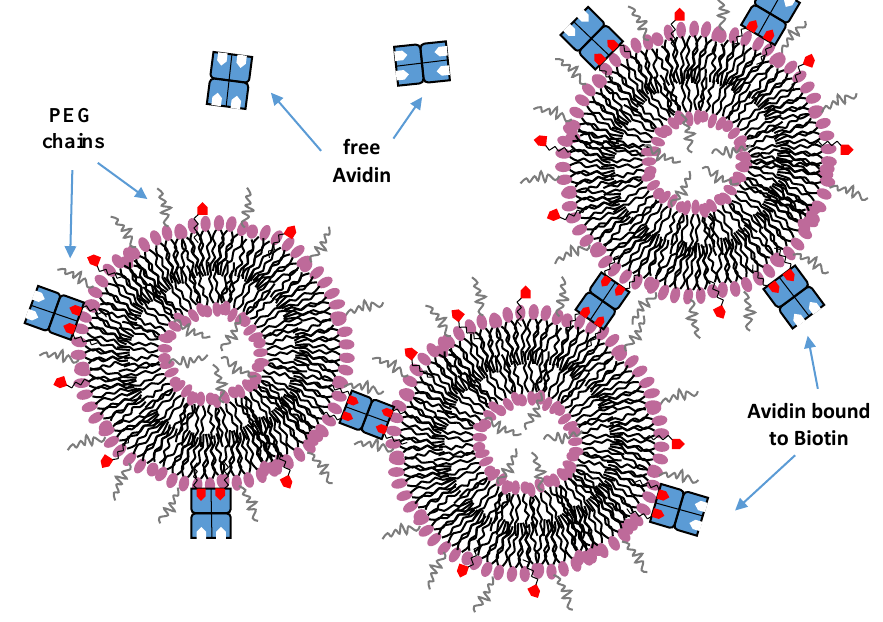
Figure 8. Representation of the aggregation of biotinylated liposomes induced by the tetrameric streptavidin protein.